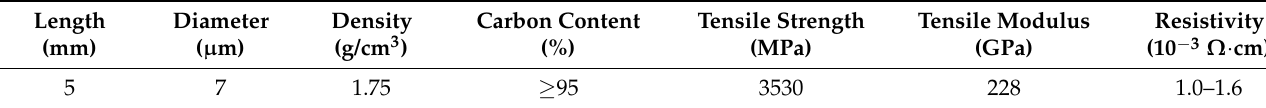
Table 4. Basic parameters of carbon